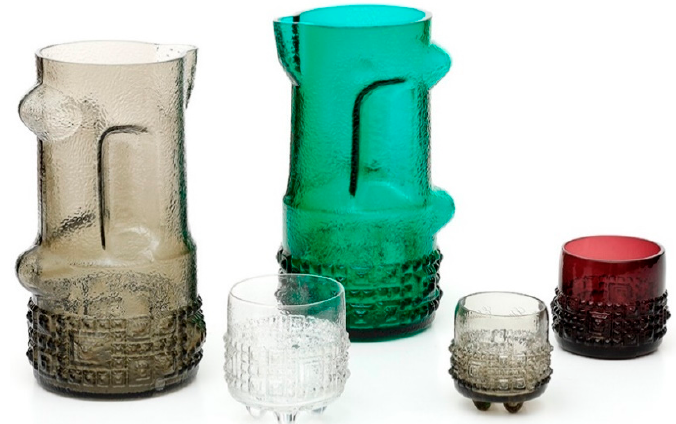
Figure 5. Orion Por , João Eduardo Marinho, Fábrica Escola Irmãos Stephens (F.E.I.S). 1971, 1970. Photo credit: photographer Jorge Soares. Arquivo do Museu do Vidro—Câmara Municipal da Marinha Grande. Private collection of Pedro Moura Carvalho.